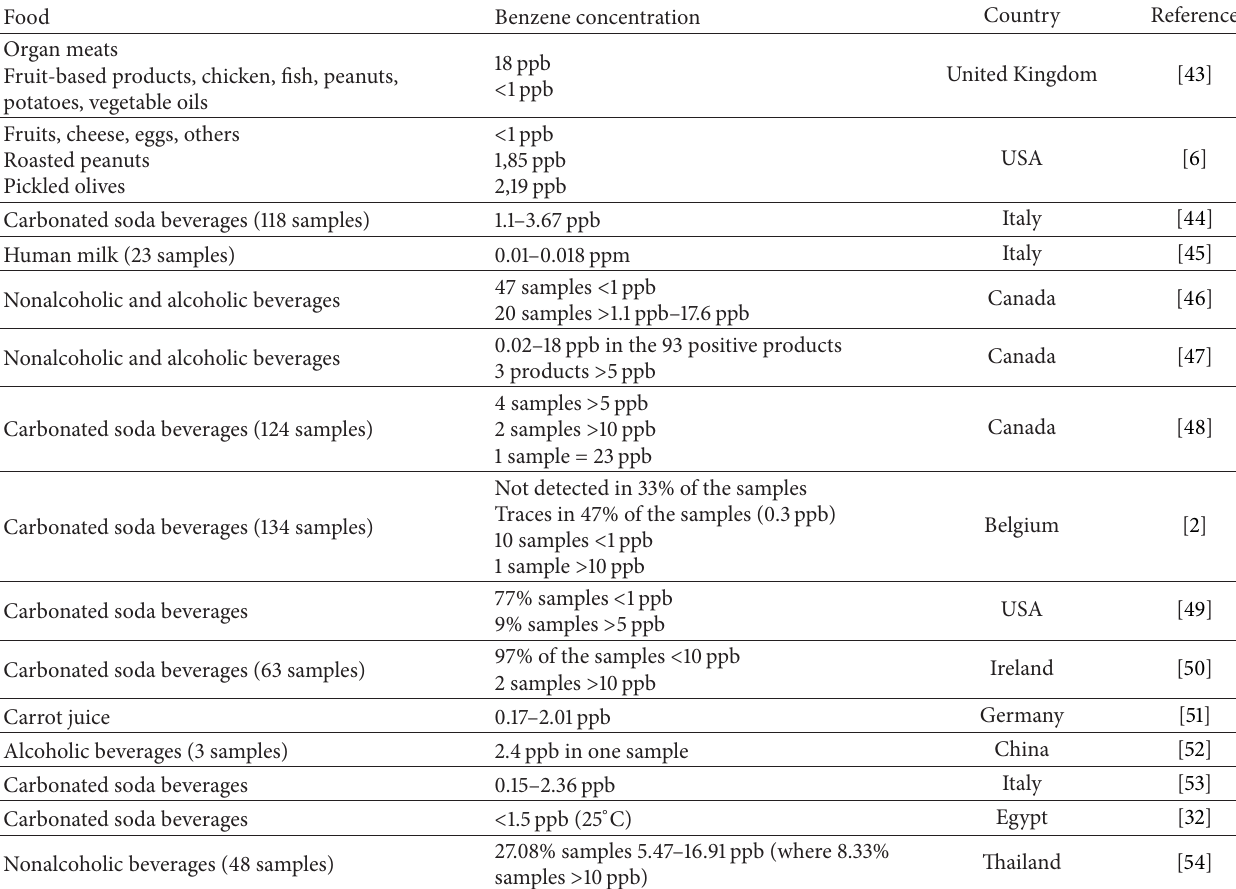
Table 1: Determination of benzene in